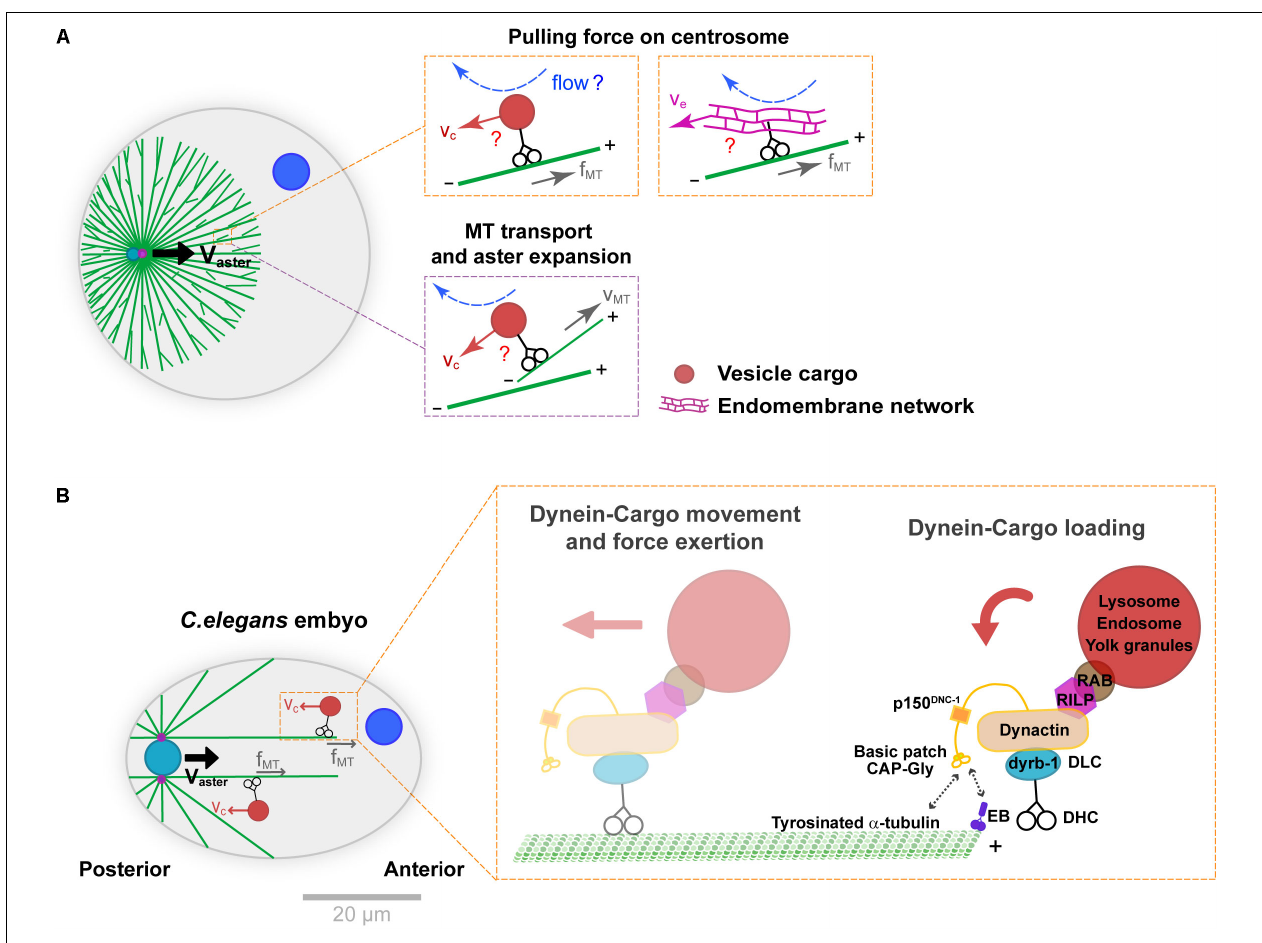
FIGURE 2 | Mechanisms supporting dynein cytoplasmic pulling force exertion on MTs. (A) Aster centration by dynein-mediated forces in bulk. Dynein may transport vesicle-cargos (e.g., endosomes or lysosomes) or large endomembrane networks like the endoplasmic reticulum (orange insets). The motion of those cargos in the viscous cytoplasm creates flows and drag forces that pull on MTs and ultimately centrosomes. This module coupled to front-rear asymmetries in MT length in asters generates a net centering force. Similar cytoplasmic forces may also transport MTs to the periphery of the asters, contributing to aster expansion (purple insets). (B) Specific subunits of the dynein-dynactin complex and adaptors thought to mediate dynein-cargo loading as well as cargo motion, during C. elegans pro-nuclear centration. The cytoplasmic dynein-cargo is loaded onto MTs by interacting with EB proteins at the plus end or tyrosinated α -tubulin along the MTs. Modified according to Kimura and Kimura (2011) and Barbosa et al. (2017). Scale bar, 20 µ